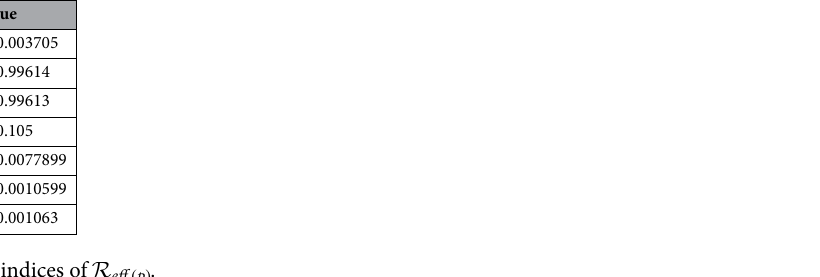
Table 3. Sensitivity indices of R eff ( p ) .